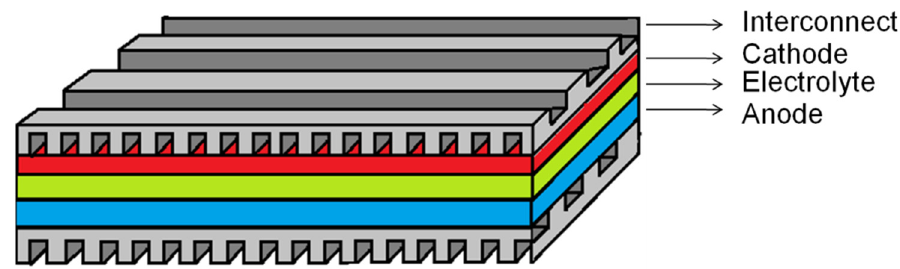
Figure 7. Schematic of typical planar type Solid Oxide Fuel Cell.